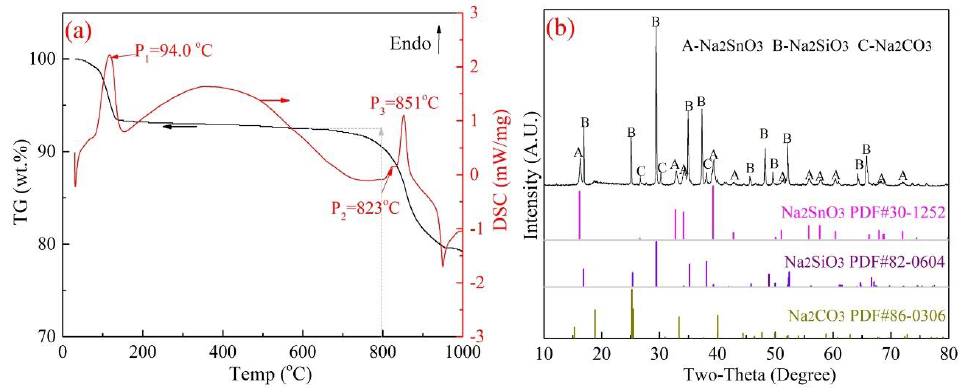
Figure 10. Reactions between Na 8 SnSi 6 O 18 and Na 2 CO 3 (( a )-TG-DSC analysis, ( b )-XRD analysis of the TG products).